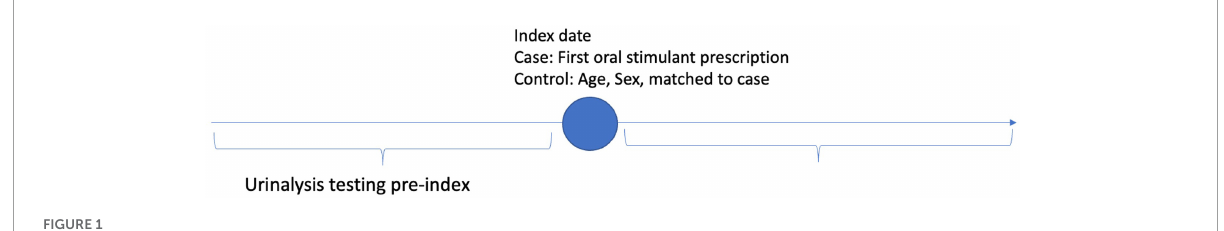
FIGURE1 Model 1-Pre-post prescription among cases and controls index